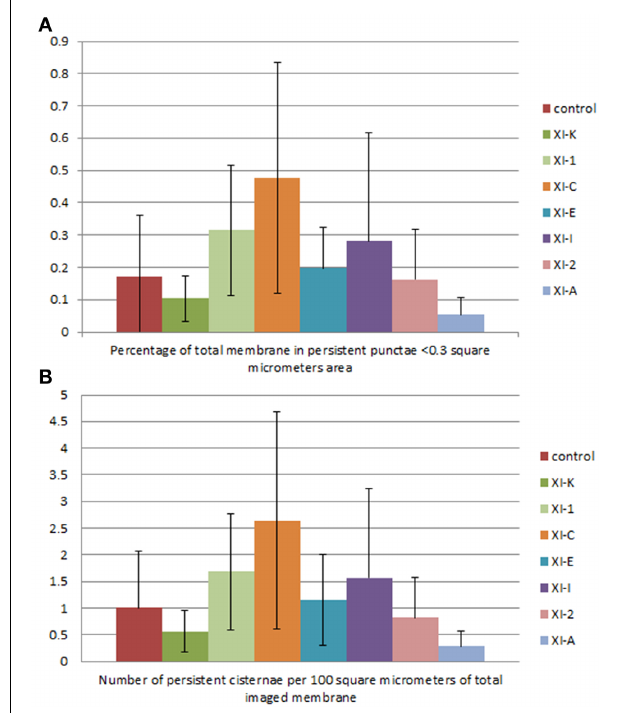
FIGURE 8 | Quantification of the effects of myosin tail domains on persistent ER punctae. (A) Counts of the cumulative percentage area of highly persistent punctae (see Figures 5 , 6 for examples). (B) Counts of the number of persistent punctae per hundred square micrometers of ER membrane analyzed for all of the myosin subclasses. Error bars represent standard deviation. The level of significance of the difference between the samples is described in Table 1